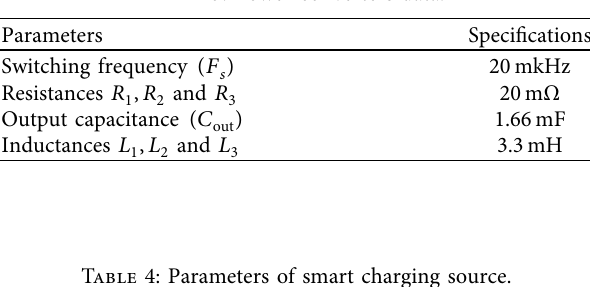
Table 3: Power converters data.